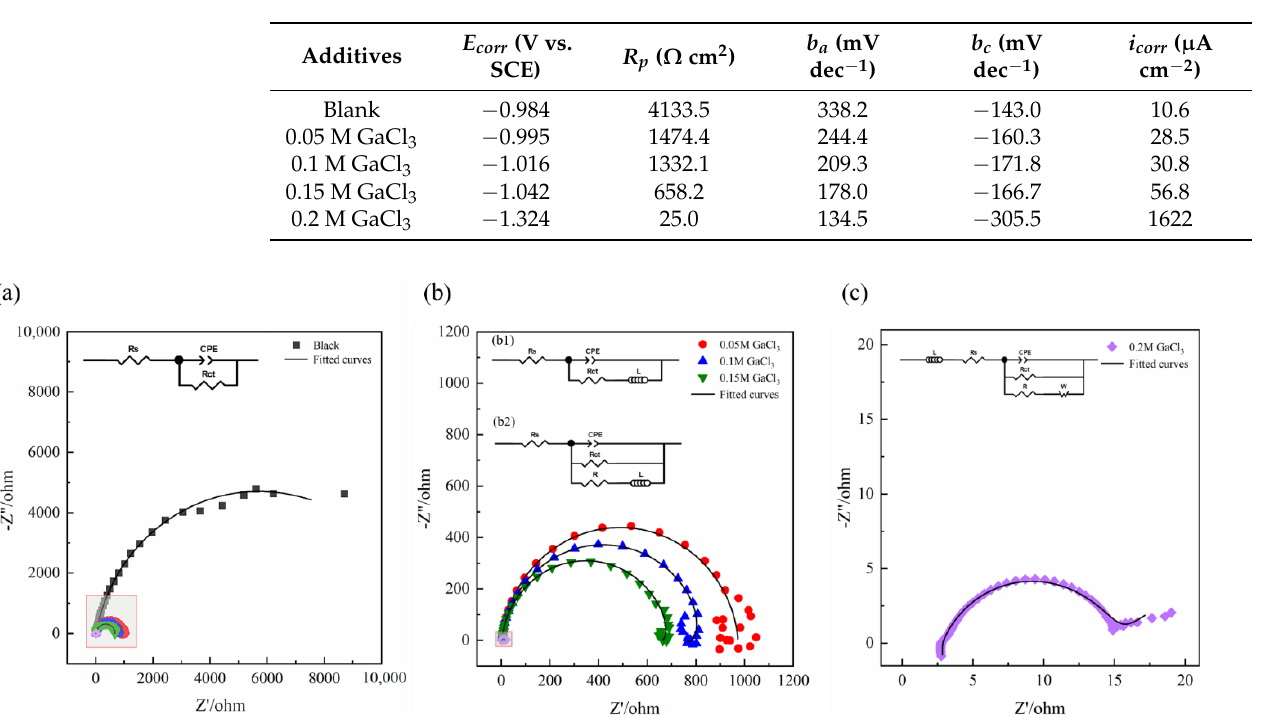
Figure 8. EIS of Al in 2 M NaCl electrolyte ( a ) without and with different contents of GaCl 3 additives: ( b ) 0.05, 0.1, and 0.15 M; ( c ) 0.2 ( b ) 0.05, 0.1, and 0.15 M; ( c ) 0.2 M.